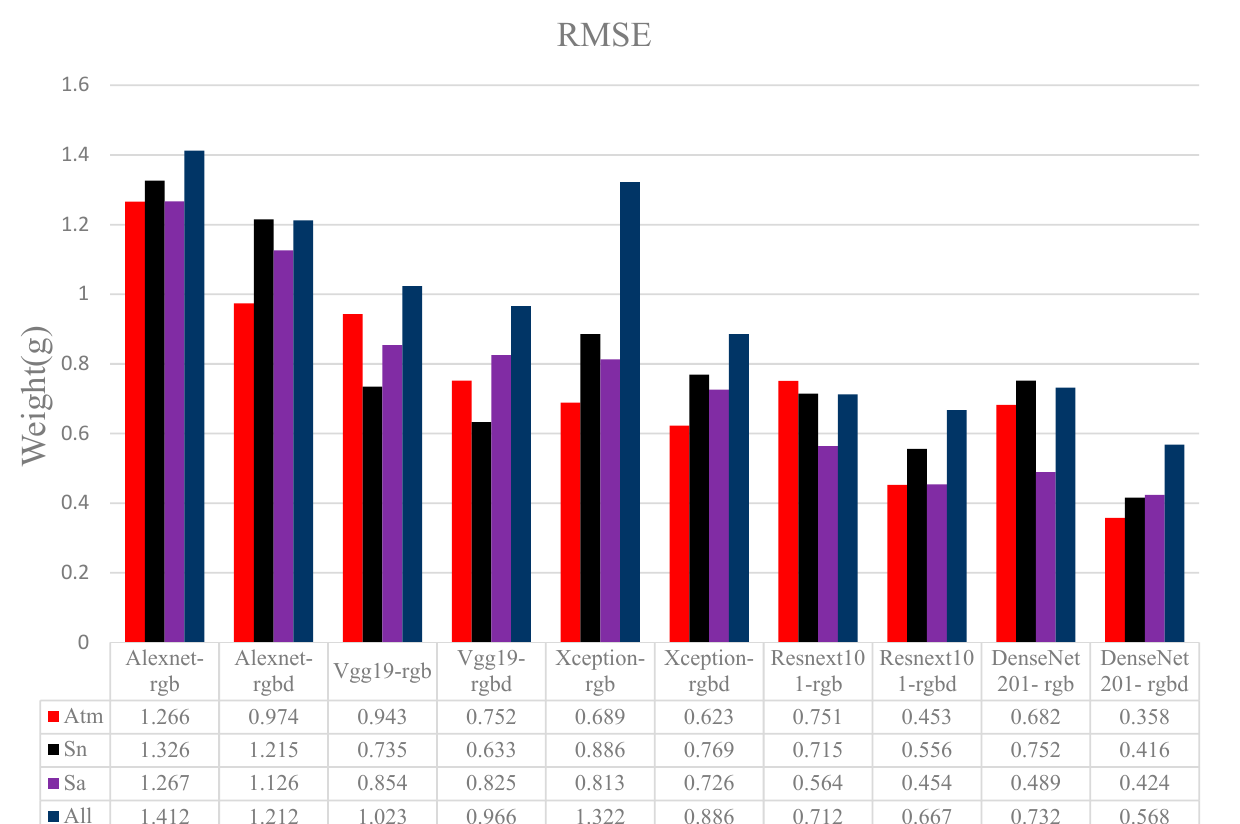
Figure 11. Comparison of weed fresh weight predictions with RMSE values. Table 4. Network average time Table 3. Network 𝑅 (cid:2870) results.